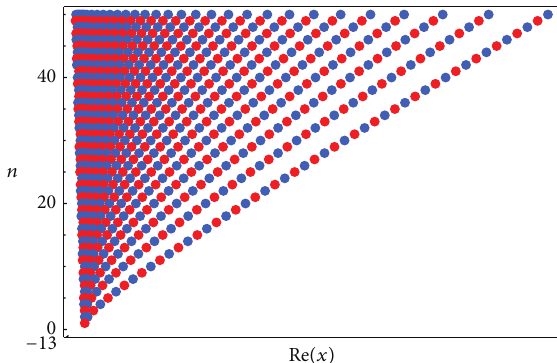
̃𝑈 (𝑥) for 1 ≤ 𝑛 ≤ 50 . 𝑛